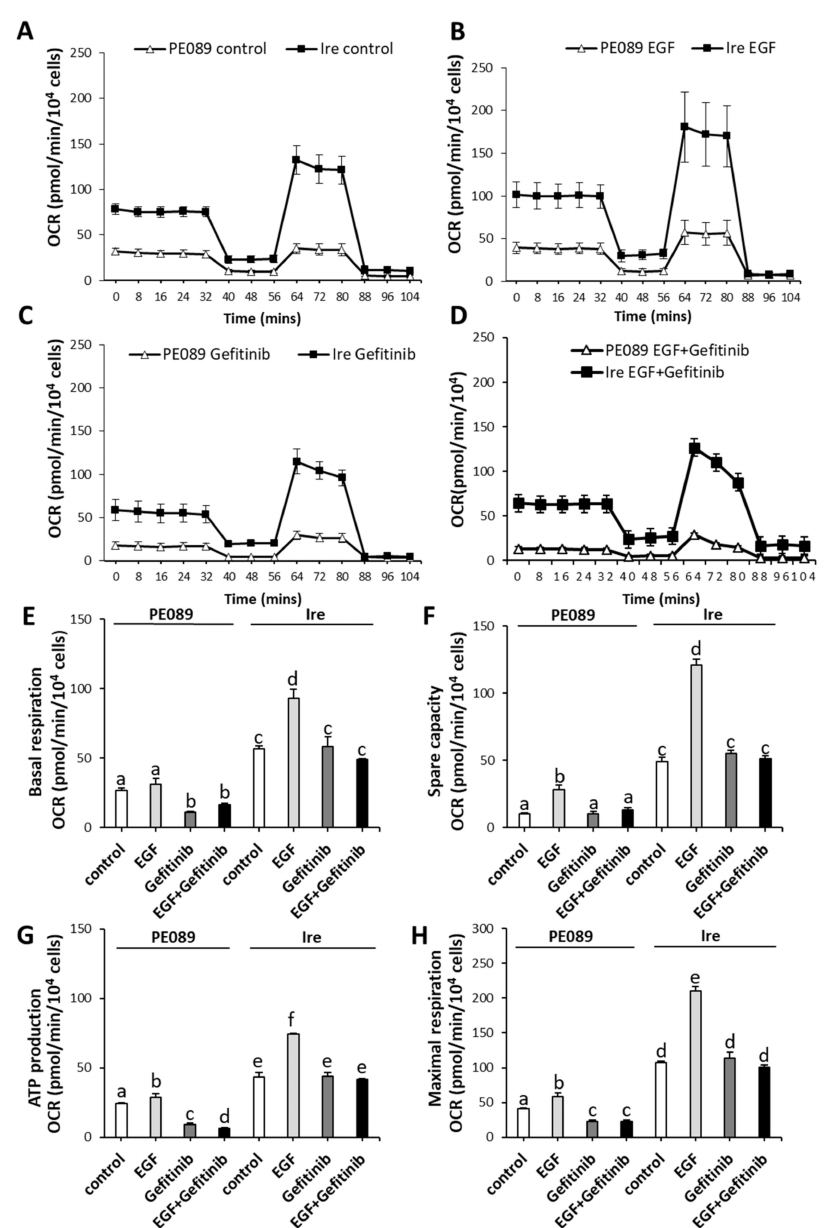
Figure 3. Ire cells exhibited higher mitochondrial bioenergetics. PE089 and Ire cells were treated with or without 100 ng / mL EGF and 1 µ M gefitinib for 24 h. The time-course progress curves of the oxygen consumption rate (OCR) are shown in ( A ) the control cells, ( B ) the EGF-treated cells, ( C ) gefitinib-treated cells, and ( D ) combined treatment with EGF and gefitinib. Individual parameters for basal respiration ( E ), spare capacity ( F ), ATP production ( G ), and maximal respiration ( H ) are represented. The values represent the mean ± S.D. from three independent experiments and each experiment performed in duplicate. The presence of the same letters on the bars indicates no significant di ff erence ( p > 0.05) between the two di ff erent conditions and the presence of di ff erent letters on the bars indicates a significant di ff erence ( p < 0.05) between the two di ff erent